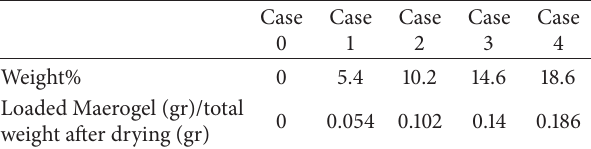
Table 1: The different loaded